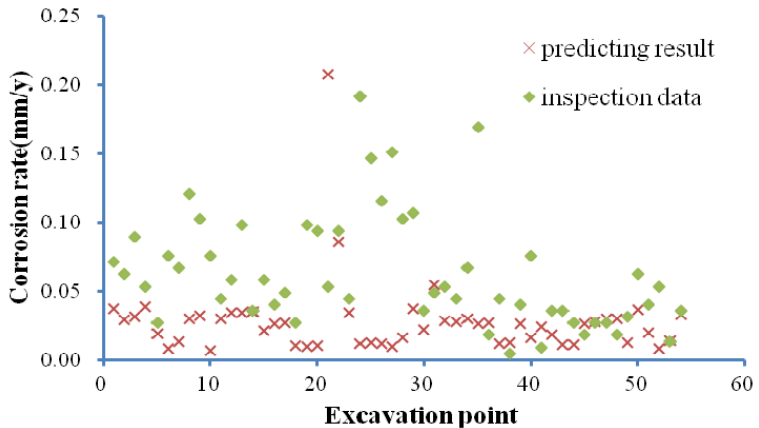
Figure 6. The predicted results and the inspection data of the validation